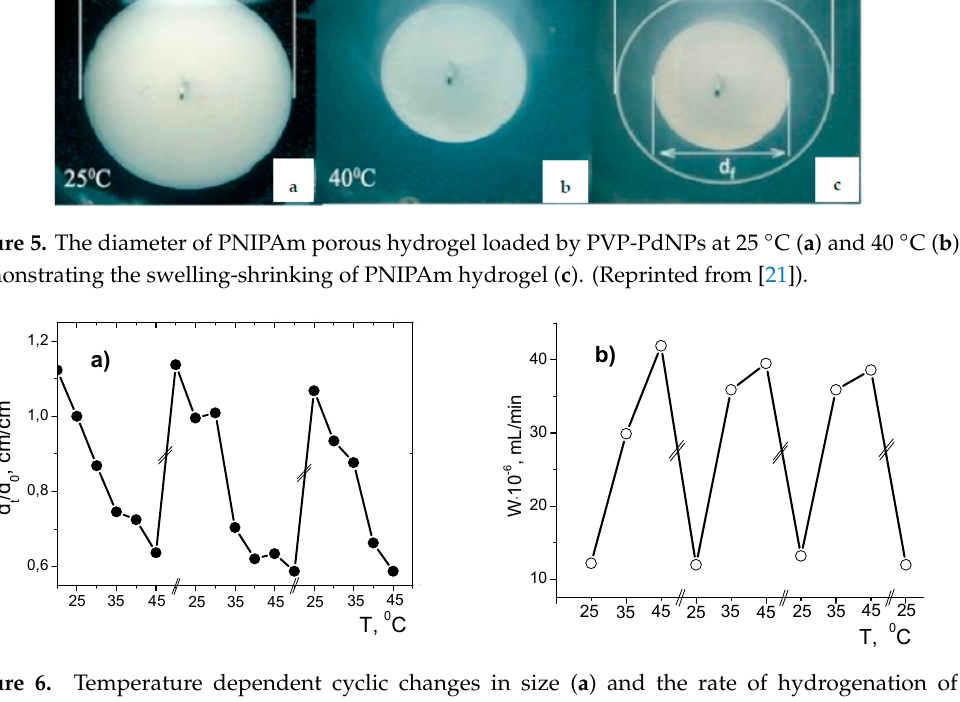
Figure 6. Temperature dependent cyclic changes in size ( a ) and the rate of hydrogenation of 2-propen-1-ol by PNIPAm / PVP-PdNPs hydrogel ( b ). (Reprinted from [21]). 3. Flow-Through Catalytic Reactors Based on Macroporous Cryogels and Metal Nanoparticles As distinct from hydrogels, cryogels synthesized in cryogenic conditions can consist of interconnected macroporous matrices with the pore size from ∼ 0.1 to 10 μ m and supermacroporous matrices with the pore size in the range from several tens to several hundreds of micrometers [23– 25]. Due to high surface/volume ratio and easy convection of liquids inside cryogel matrices, both macroporous and supermacroporous cryogels are proved to be the most favorable materials to design flow-through catalytic reactors [7,26,27] (Figure 7).